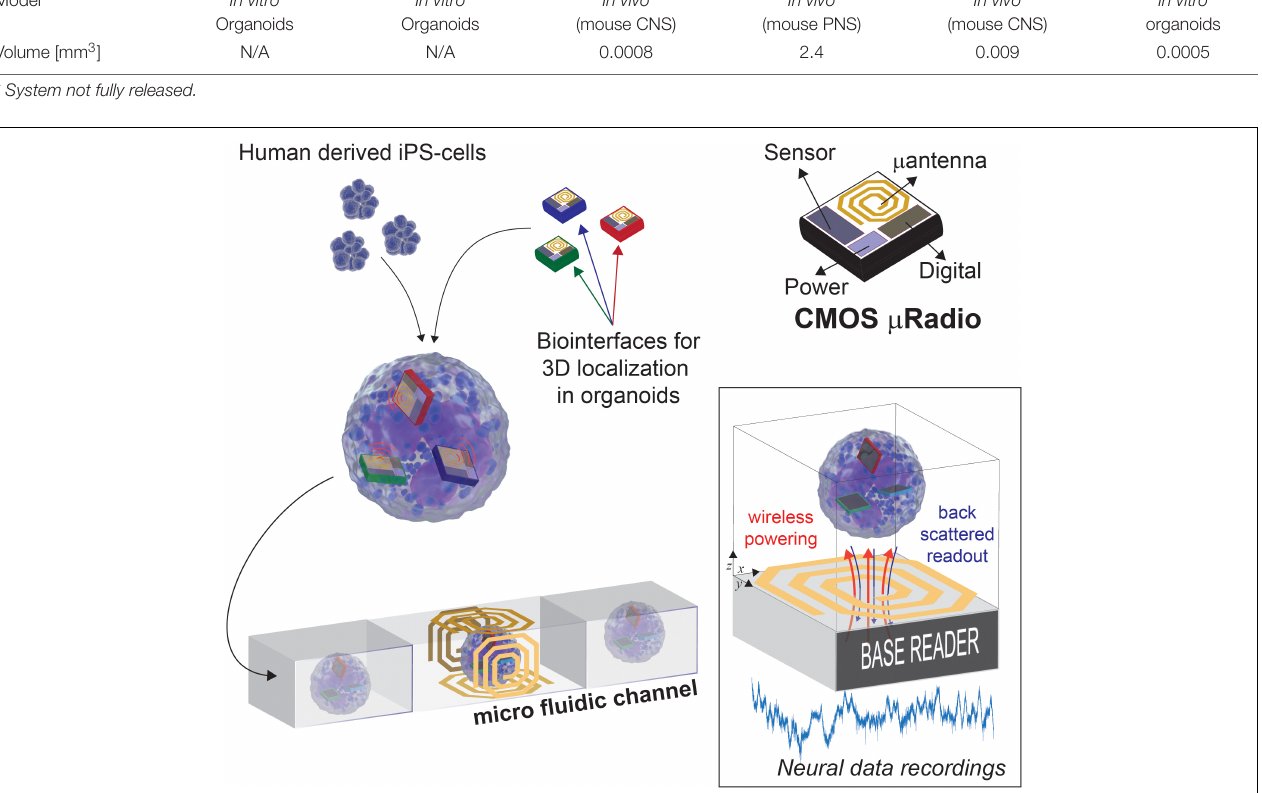
FIGURE 1 | Concept view of Lab-in Organoids : active devices seamlessly integrated into developing organoids can be used for monitoring their bioelectrical activity over the entire life span.